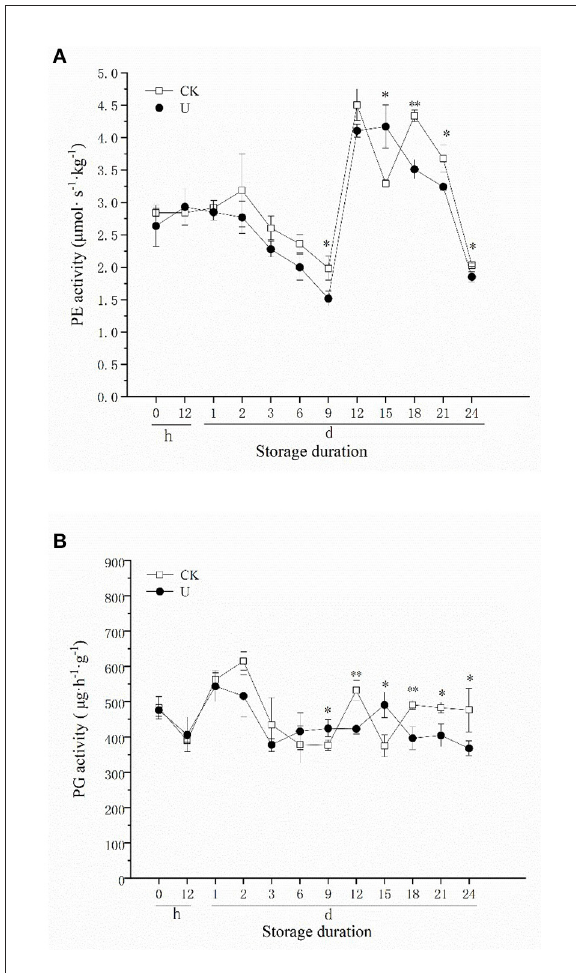
FIGURE3 Effect of ultrasound on PE (A) , PG (B) activities in strawberries during storage. Data represent the means ± SE, n = 3. According to independent t-tests, asterisks indicate significant difference (* P < 0.05, ** P < 0.01) between CK and U treatments at the same time point.